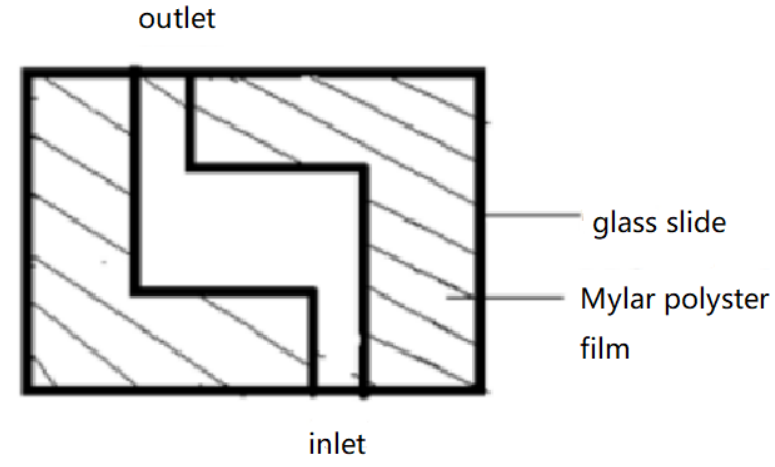
Figure 3. ‘L’-shaped cell for LC–solid interface sensing.